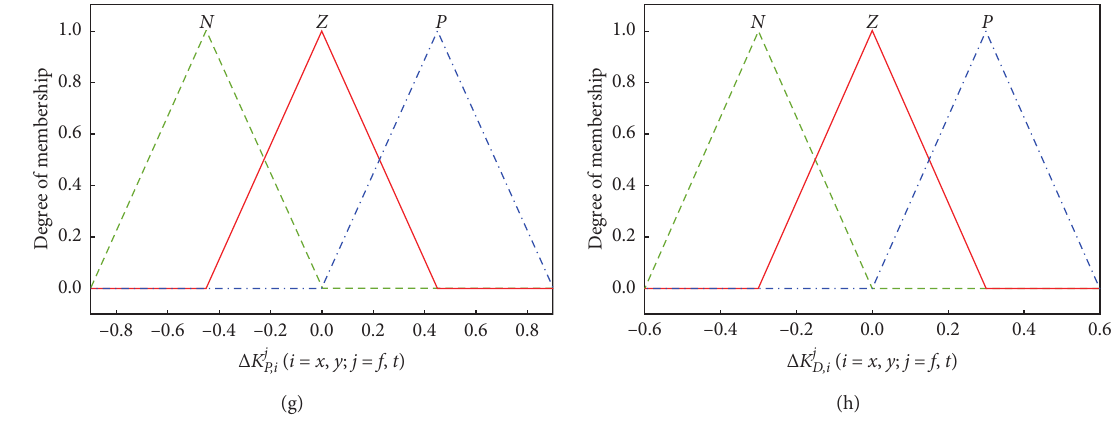
Figure 17: Membership functions (MFs) chosen for both inputs and outputs of each fuzzy